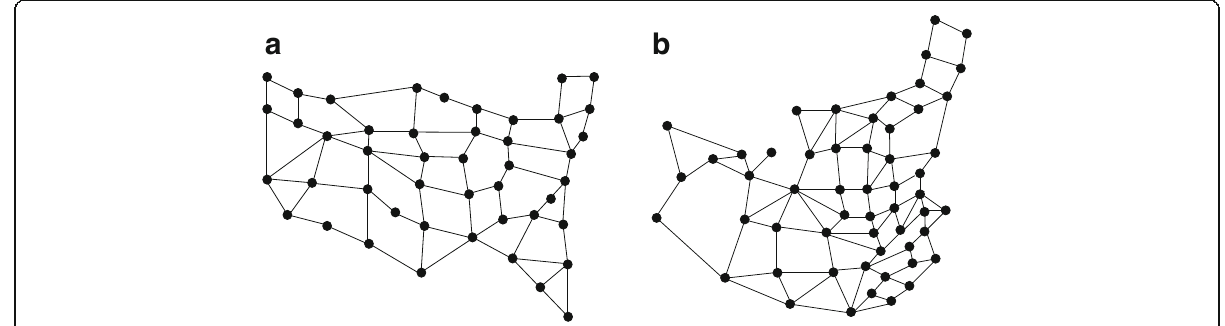
Fig. 5 Physical networks used in our simulations. a Net-1: a network with 46 nodes. b Net-2: a network with 55 nodes